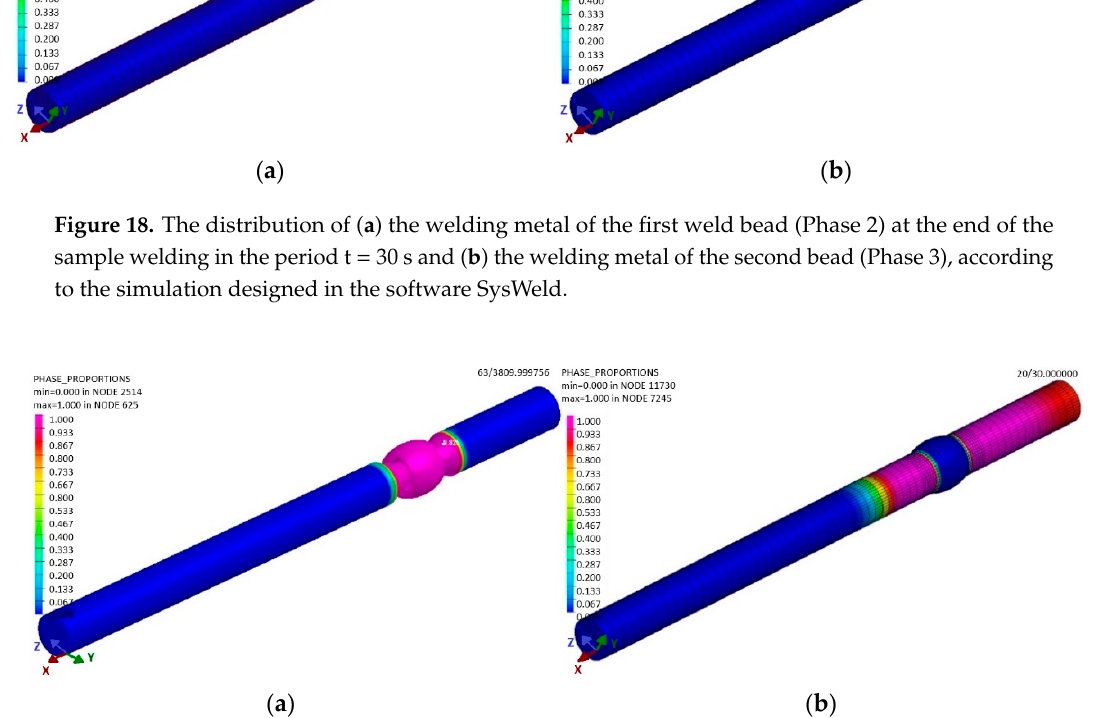
Figure 19. The distribution of the filler material in the sample ( a ) after cooling and ( b ) the heat distribution in the affected area in the period t = 30 s, according to the simulation designed in the software SysWeld.